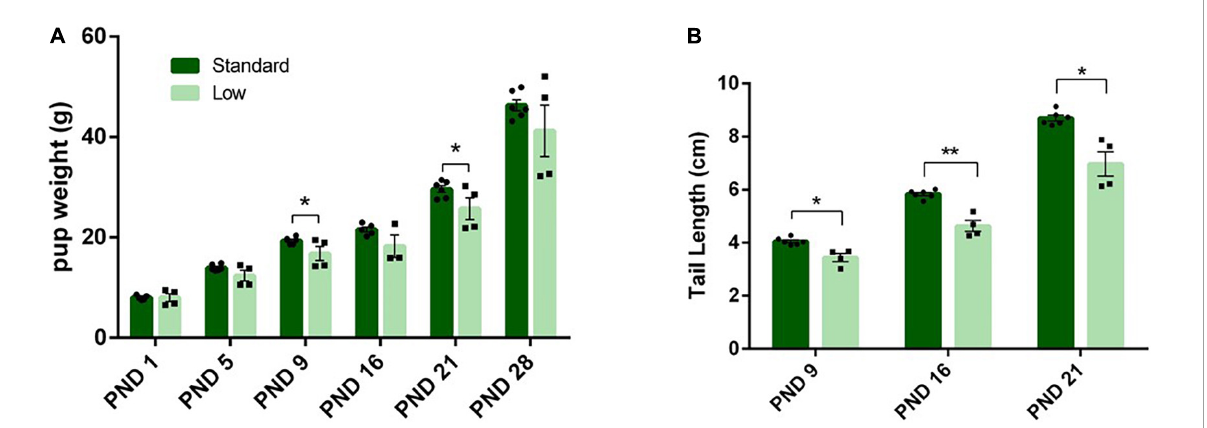
FIGURE8 Physical characteristics. Across early postnatal development, a series of measures were collected such as weight gain (A) , and tail length (B) , among others. (A) Pup weight (individual data represented as litter average) is shown to increase across time in both standard- ( N = 6) and low resource conditions ( N = 4); however, standard raised pups were significantly heavier at PND 9 and 21(* p = 0.043) compared to low resource pups. (B) Tail lengths (shown as litter average) were also significantly shorter in low-resource pups at PND 9 (* p = 0.012), PND 16 (*** p = 0.001), and PND 21 (* p = 0.01) compared to standard resource pups. Bars represent means ± SEM with individual litter data points shown in overlay.